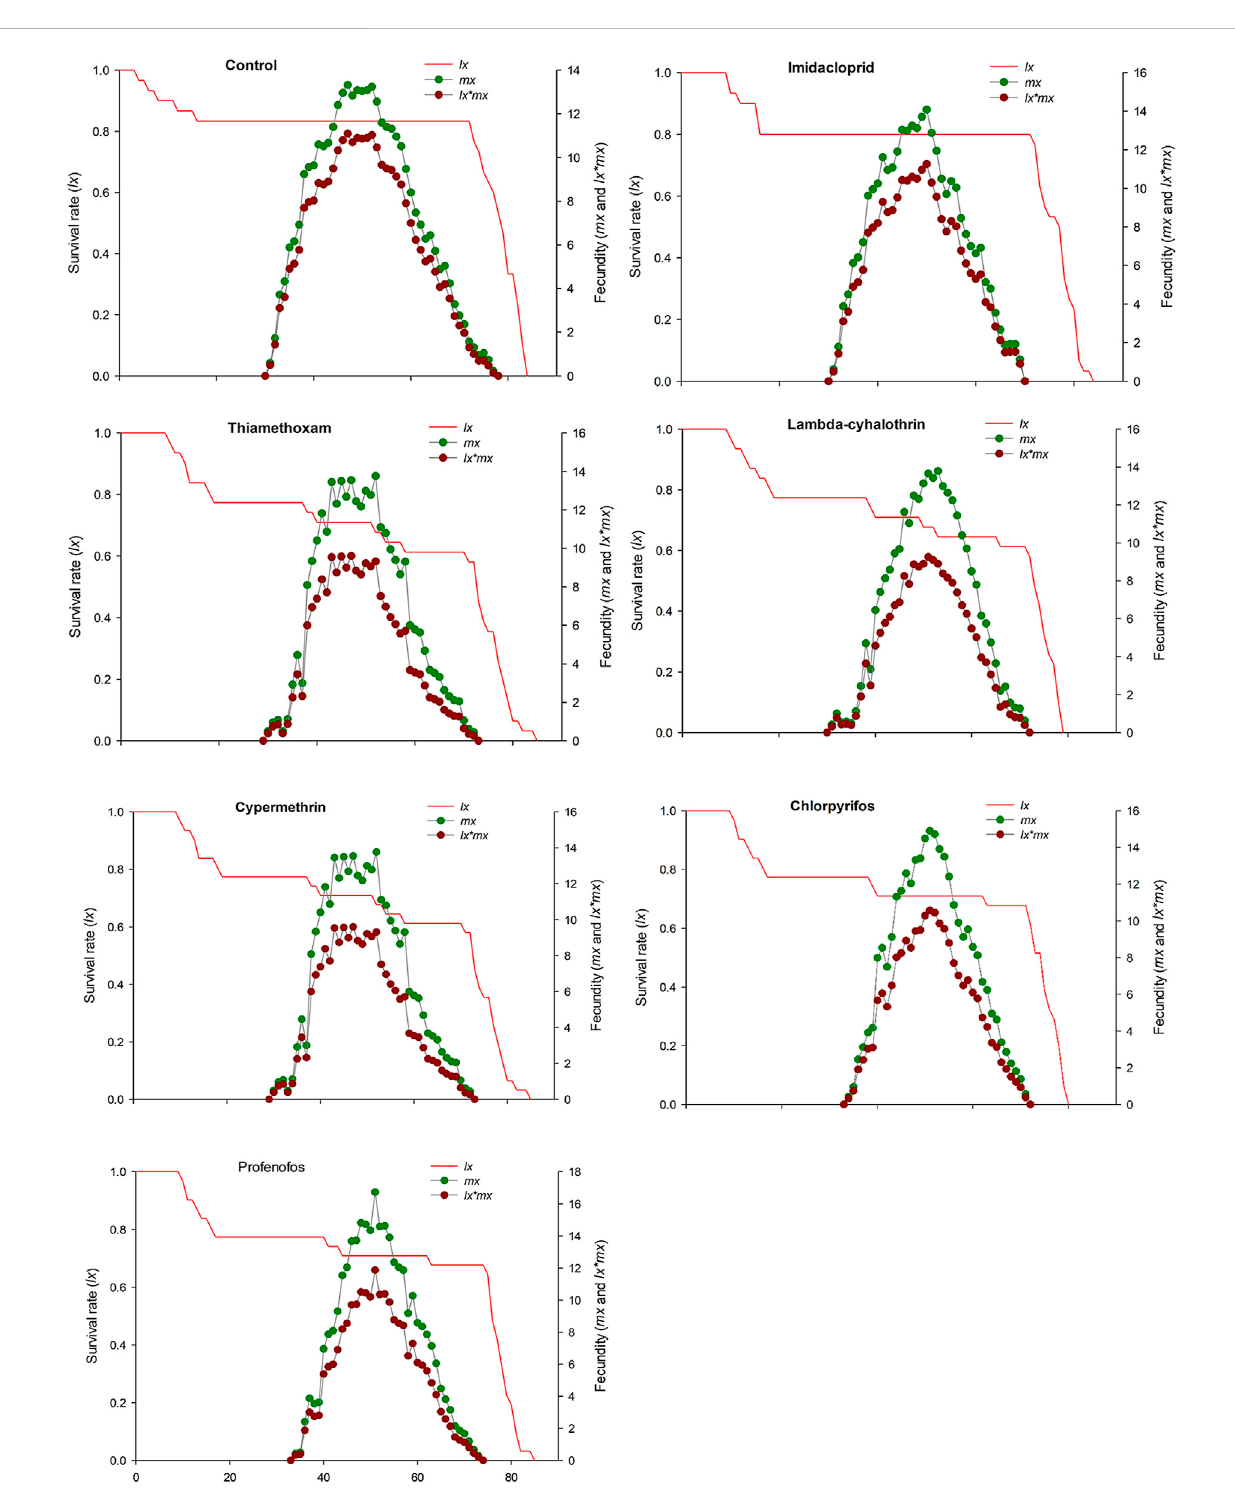
FIGURE 4 Age-stage speci fi c survival rate ( lx ), age-speci fi c fecundity ( mx ) and net maternity ( lx × mx ) of C. septempunctata (F 1 ) treated with water (control) and sublethal concentration